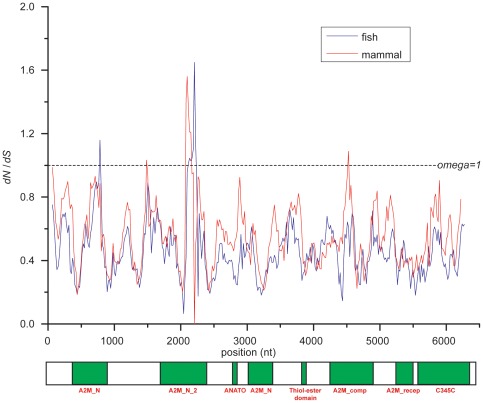
Sliding window analysis of variation in omega value along fish and mammalian C3 genes.It was set to be 90 bp for the window size and 36 bp for the step size. Beneath the plot is a schematic of the C3 gene, which illustrates the distribution of the characteristic domains.